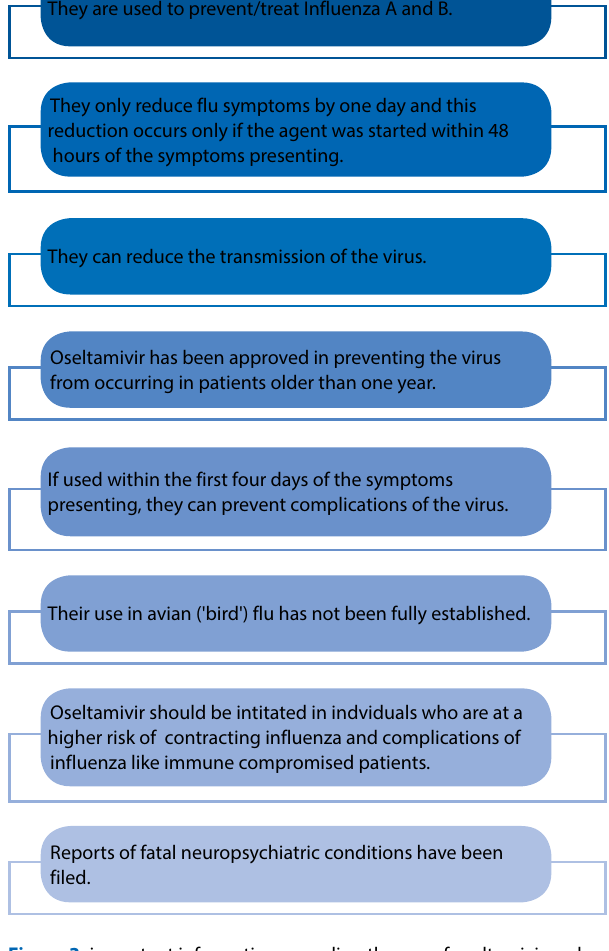
Figure 3: important information regarding the use of oseltamivir and zanamivir 1, 18 Table 5: Important differences between zanamivir and oseltamivir 1, 18 .